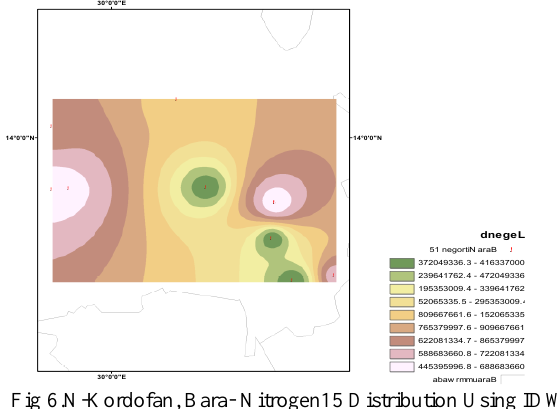
Fig 9. Bara Nitrate (NO 3 ) concentration mg/l